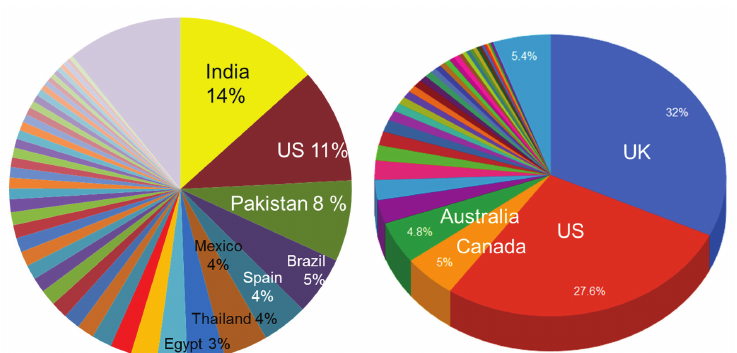
Figure 5. As of December 2014, the geographical origins of followers of Teaching Tools in Plant Biology feeds on Facebook (left, >3600 followers) and Twitter (right, >2200 followers) are quite different, with Twitter followers showing a strong bias towards countries whose primary language is